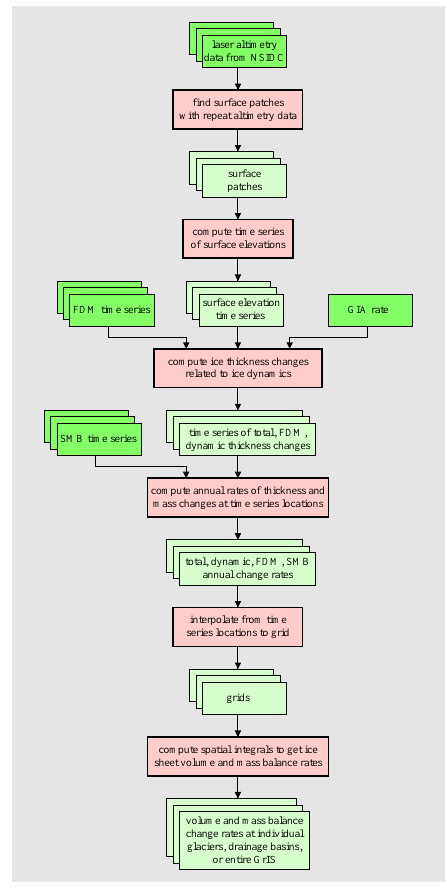
Figure 1. Overview of SERAC with major computing modules (red boxes) and data sources (green boxes). Light green boxes are indicating SERAC internal data structure while dark green boxes are external data.